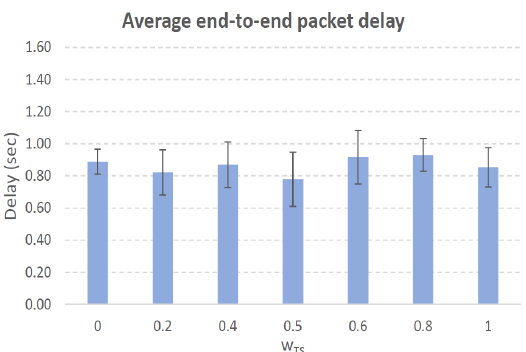
Figure 11. Average end-to-end packet delay. Scenario with low social media interaction (TS normal distribution with µ = 2 and σ = 1). Nodes’ density = 200 nodes/km 2